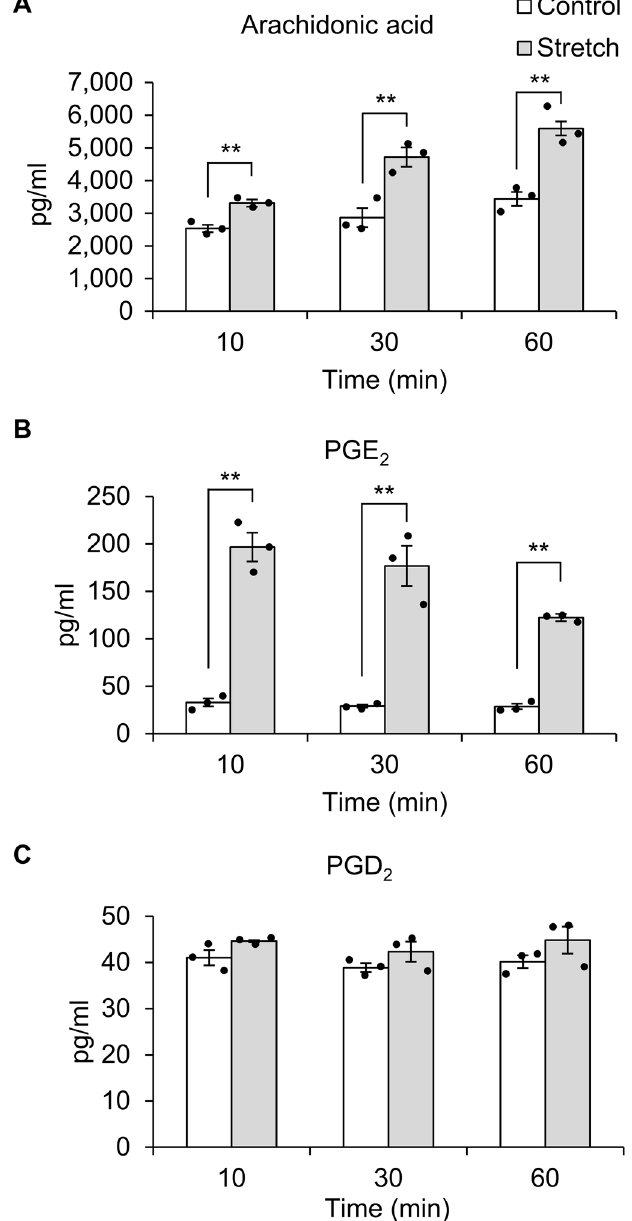
Figure 4. Mechanical stretch stimulation induces the release of arachidonic acid and PGE 2 in human trabecular meshwork cells. Cell supernatants were collected 10, 30, and 60 min after a single uniaxial stretch stimulation and subjected to lipid analysis. Mechanical stretch stimulation in human trabecular meshwork cells triggered the release of arachidonic acid ( A ) and PGE 2 ( B ), but not PGD 2 ( C ). Data are expressed as means ± SE (n = 3 samples of lipid mediators extracted from cell supernatant in 3 chambers). ** p < 0.01, two-tailed Student’s t